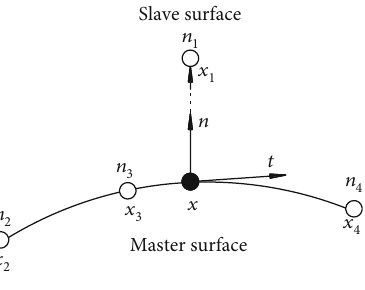
Figure 5: Quadratic slide line